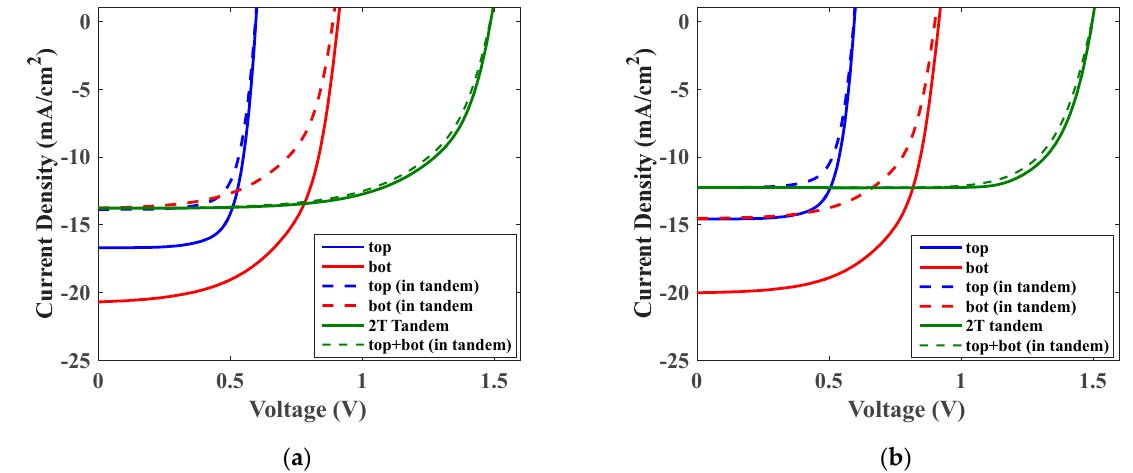
Figure 6. Illuminated J-V characteristics based on tandem parameters extracted from ( a ) optical simulation and ( b ) full optoelectronic simulation.